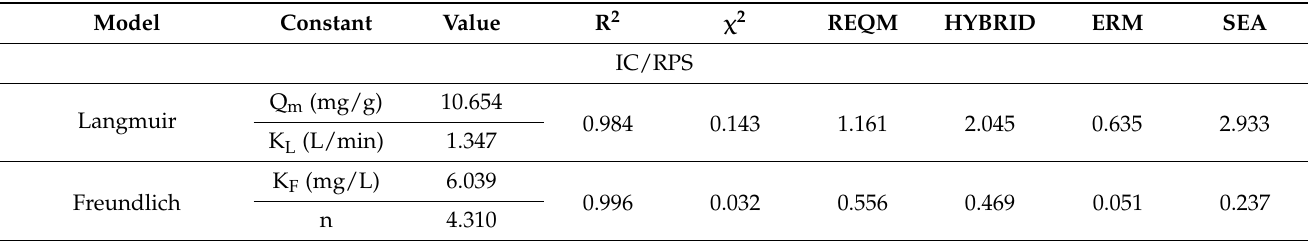
Table 8. Data from the Langmuir, Freundlich, and D–K–R isotherms for the sorption of IC by RPS, PST1, and PST2